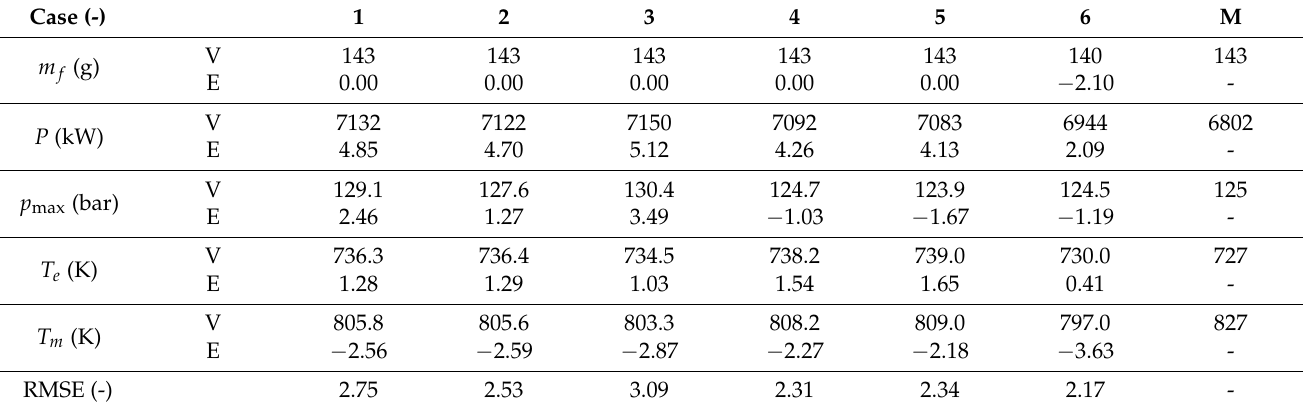
Table 11. The performance of the dual-fuel engine running in fuel sharing mode with the SL